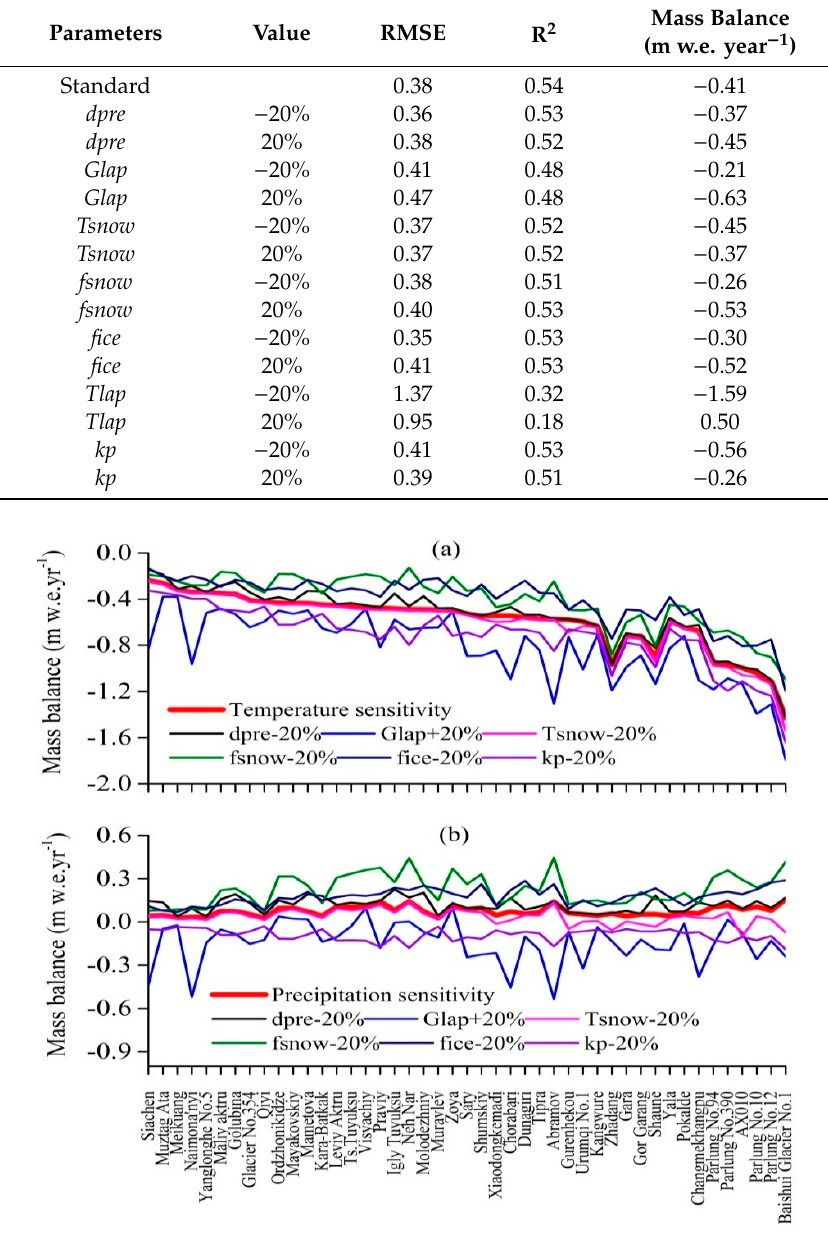
Figure 7. The influence of parameter perturbations on the mass balance sensitivity to ( a ) +1 K temperature change and ( b ) +10% precipitation change.